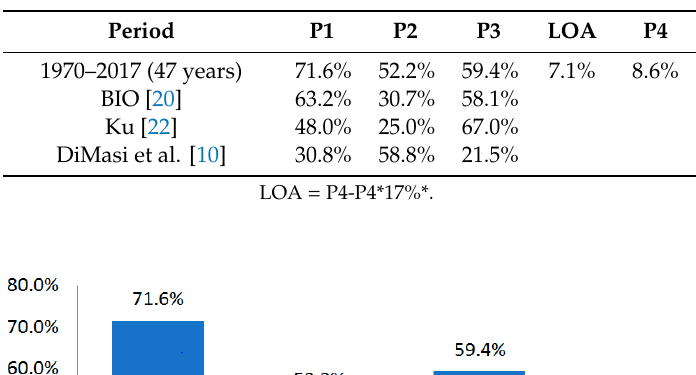
Table 12. Conversion (approval) rate in each NDA clinical phase for the whole period (1970–2017).